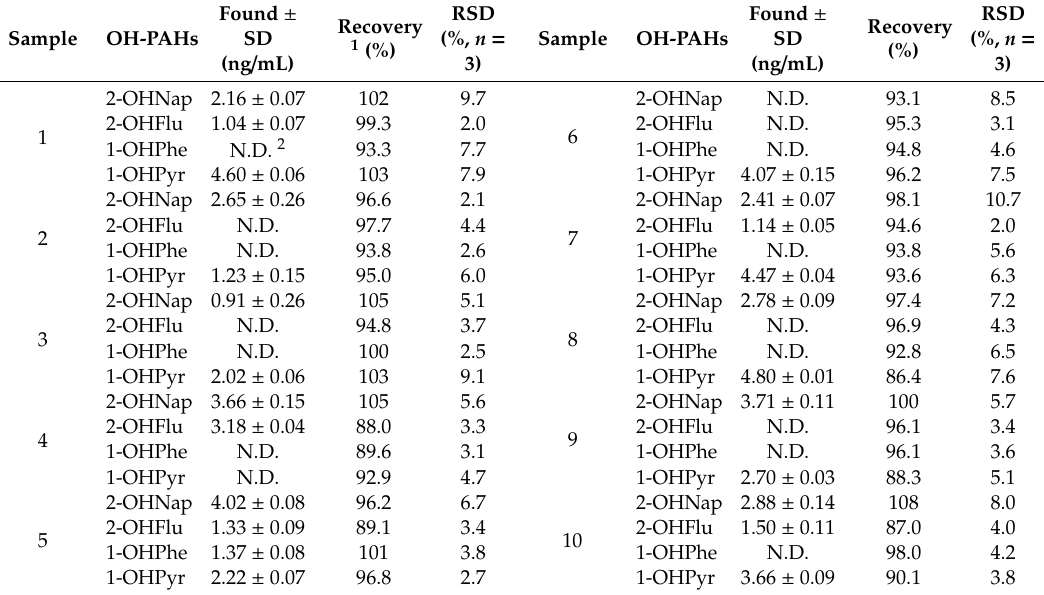
Table 3. Analytical results for the determination of Hydroxylated PAHs (OH-PAHs) in urine samples from 10 smokers ( n =